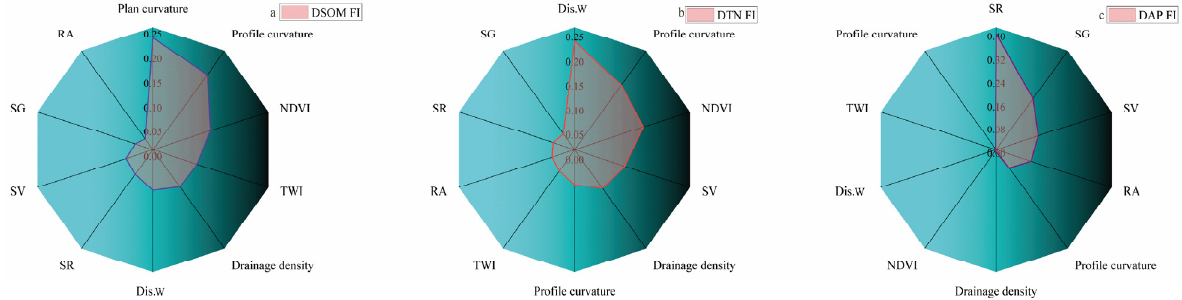
Figure 4. Feature importance of each environmental factor on DSOM ( a ), DTN ( b ), and DAP ( c ), RA, relief amplitude; SG, slope gradient; SV, variation of slope gradient; SR, surface roughness; Dis.W, distance to working panel margin; TWI, topology wetness index.